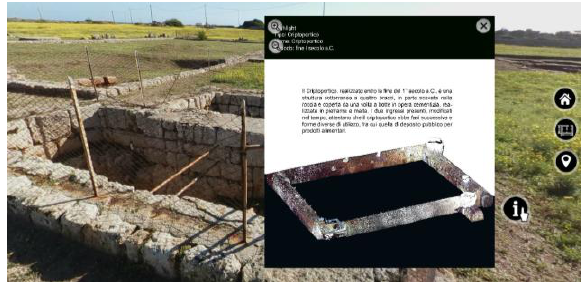
Figure 11. Visualisation of an historical datasheets in the VT_RGB